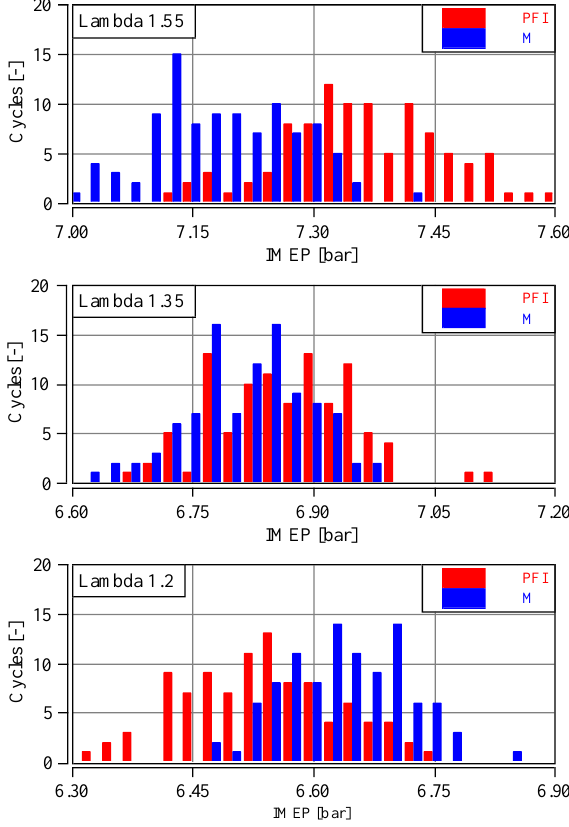
Fig. 7. Histogram of indicated mean effective pressure for three different lambda values The maximum pressure in the cylinder was then taken into account, as well. This is one of the important